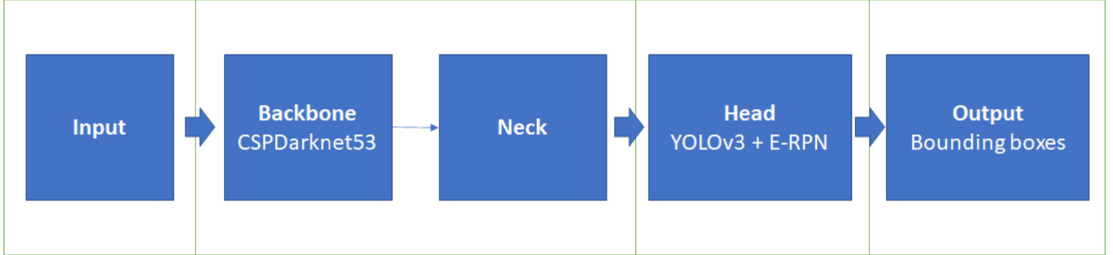
Figure 2. Architecture of YOLOv4 algorithm.